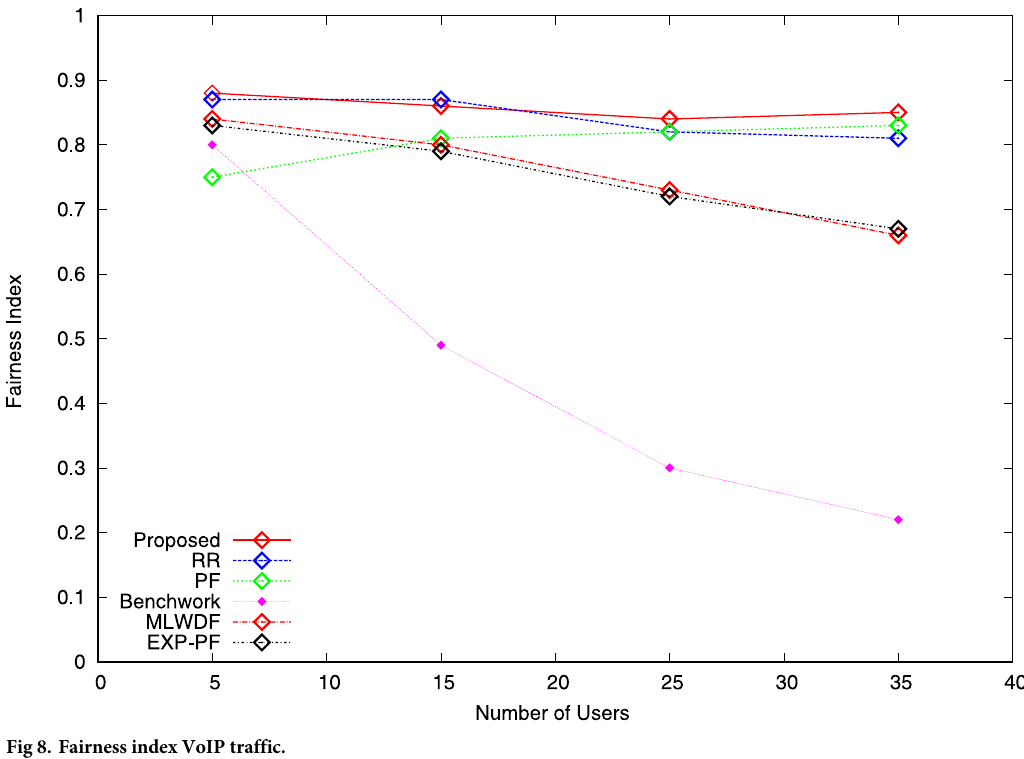
Fig 8. Fairness index VoIP